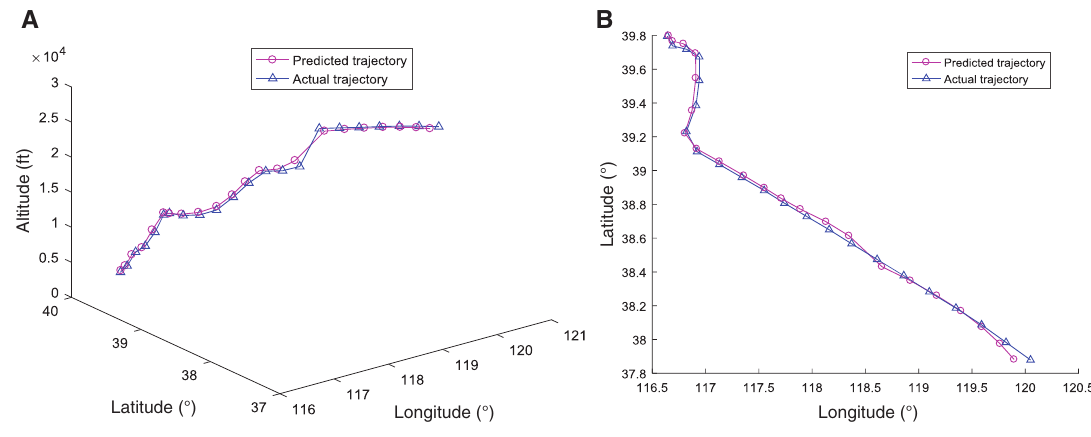
Figure 8: Trajectory Prediction of CES5193 Flight. (A) 3D prediction of the trajectory and (B) latitude and longitude prediction of the trajectory.